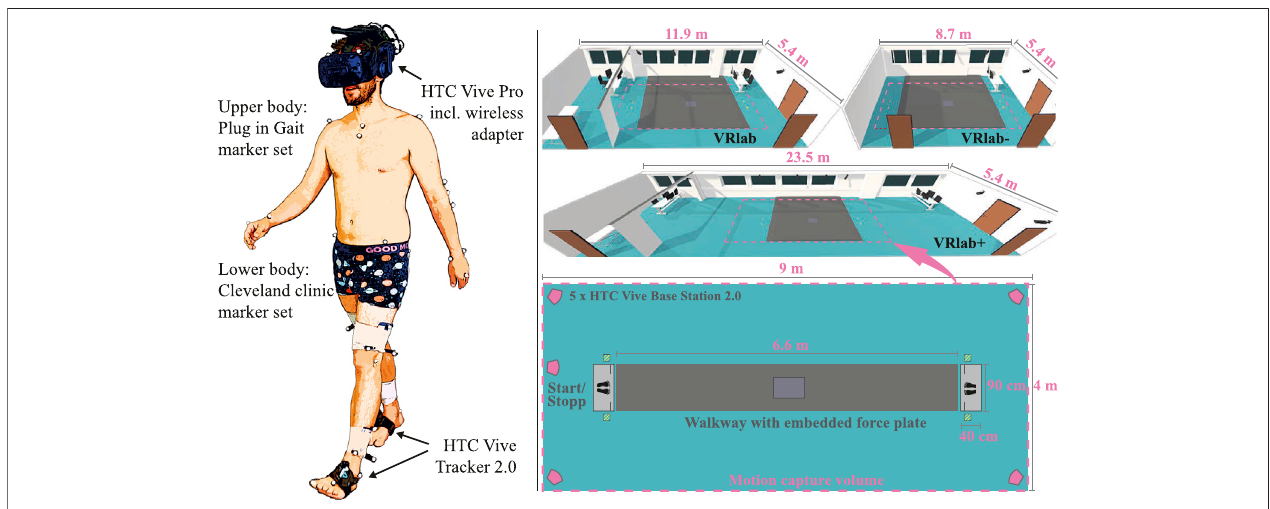
FIGURE 1 | Left: The Cleveland Clinic marker set was used for the lower body and the Vicon Plug-In-Gait model for the upper body. A wireless operated HTC Vive ProwasusedtodelivertheVRenvironment.HTC Vive2.0trackerswereusedtotrackthepositionsofthefeetinreal-timeanddisplaythemintheVR.Right:Participants walked in a random order in the real lab and three VR-versions of the lab, one resembling the real one (VRlab), one down-sized lab (VRlab − ), and one over-sized lab (VRLab+). The pink dashed line shows the approximate position of the motion capture volume (of the real-world) in respect to each virtual environment.